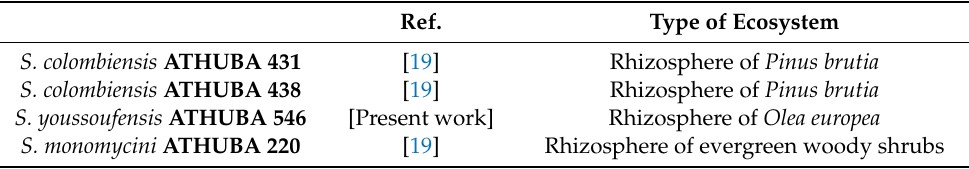
Table 2. Description of the sites where the nematicidal isolates were recovered from.